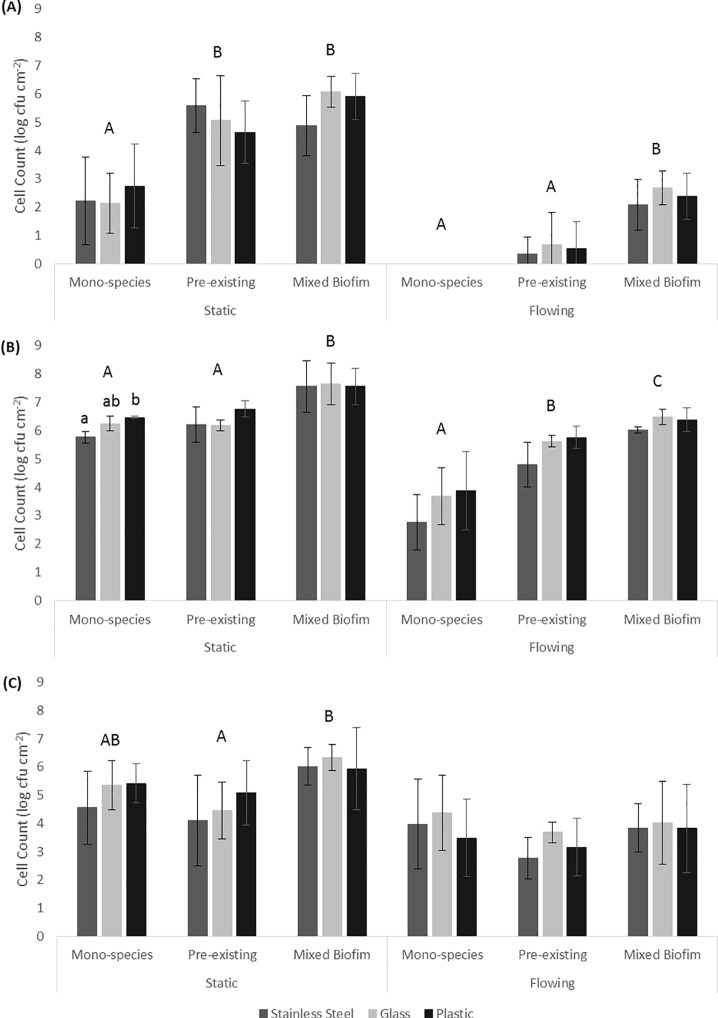
Cell counts of C. jejuni (A) strain 2868, (B) strain 2871 and (C) strain ATCC 33291 attached to different abiotic surfaces (stainless steel, glass or plastic) alone or in association with P. aeruginosa under static or flow conditions. All results are presented in mean ± SD where n = 3. Different uppercase letters represent significant difference (p<0.05) between the cell count of the bacteria under different conditions within static or flow conditions. Different lowercase letters represent significant difference (p<0.05) between the cell count of the bacteria on different surfaces.